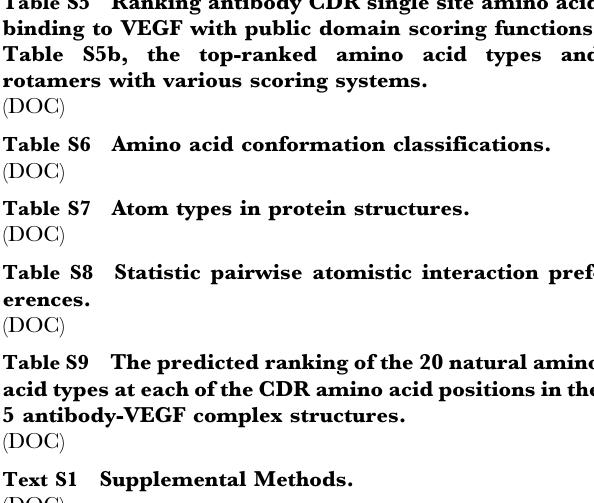
Figure S1 Flow chart depicting the procedure in con- structing probability density maps (PDMs) for non- covalent atomistic interactions on protein surfaces. Table S1 Sequence information and VEGF-binding and expression data for the scFv variants shown in Figure 1. Table S2 Sequence information and VEGF-binding and expression data for the sc-dsFv variants shown in Figure 1. (DOC) Table S3 Data collection and refinement statistics for the sc-dsFv x-ray crystallography. (DOC) Table S4 Leave-one-out cross validation predictions for the amino acid preferences at each of the 30 CDR interface residues.